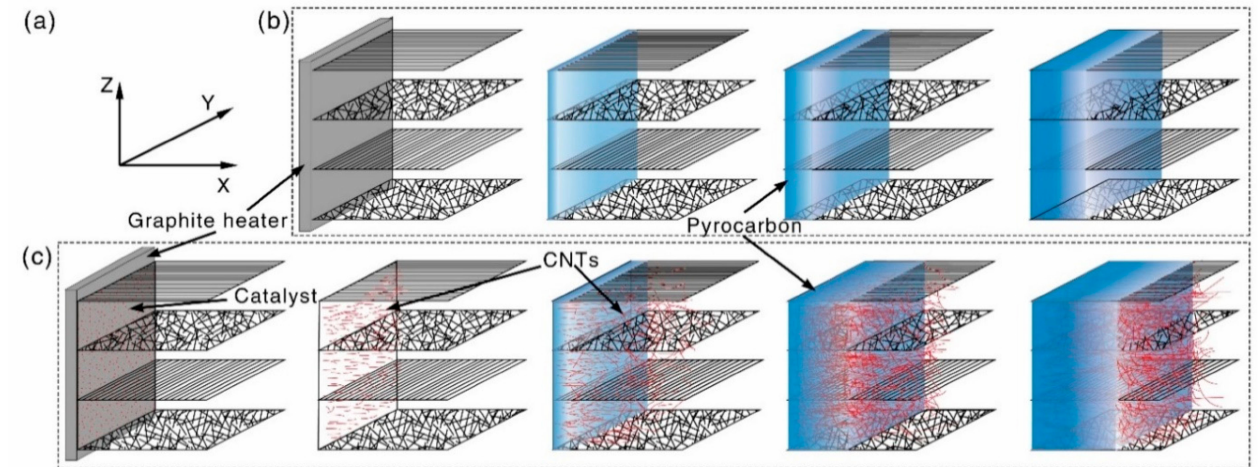
Figure 1. ( a ) Directions of the layered 2D needle-punched carbon fiber preform, the densification process was along X axis; Densification process of ( b ) traditional C/C composites and ( c ) CC/C